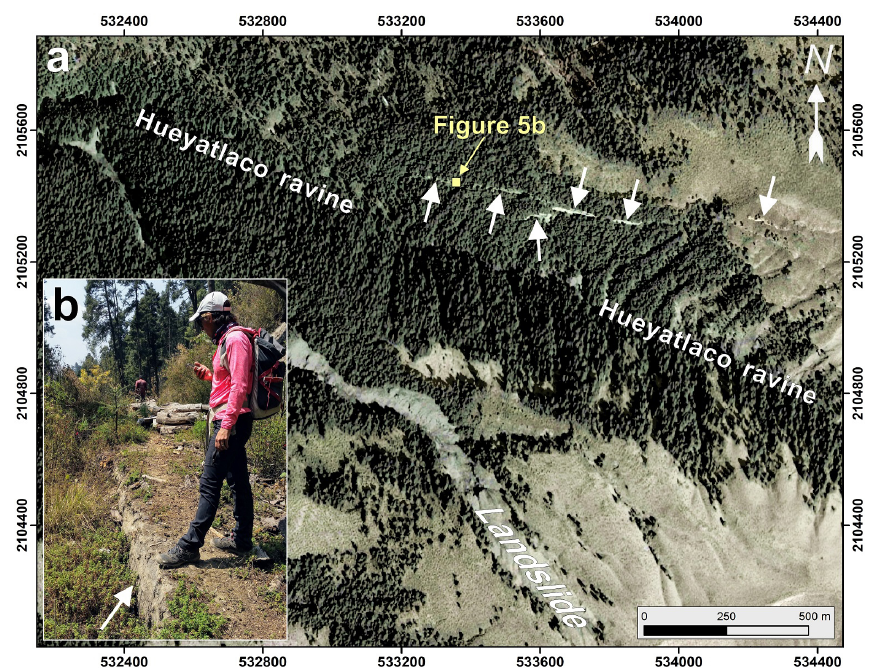
Figure 5. (a) Rectilinear extensional fractures and small normal faults opened parallel to the Hueyatlaco ravine (white arrows); background image: Pléiades 1A image acquired on 13 November 2017. (b) Detail of the normal displacement of about 50cm (white arrow). Coordinate system WGS84 UTM Zone 14Q. Table 1. Main morphometric data of the landslides that occurred in the headwaters of the Hueyatlaco, Huitzilac, and Xalipilcayatl ravines. The area of the main scars was inferred from the inspection of post-event optical images (see Fig. 8). The depth of the scars was measured in the field. The volume of the landslides was calculated assuming a constant depth (with an uncertainty of ± 0.5m) over the area of detachment. Max